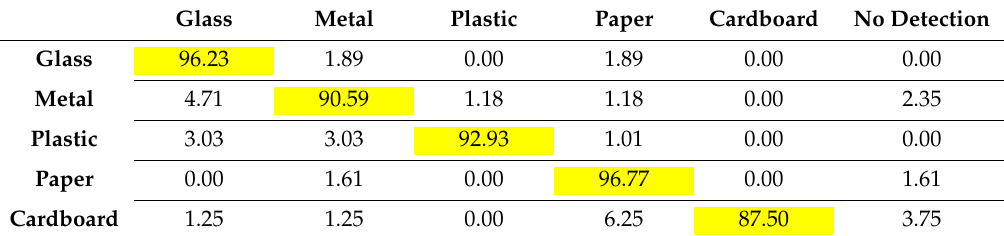
Table 1. SSD-MobileNetV2 Confusion matrix.